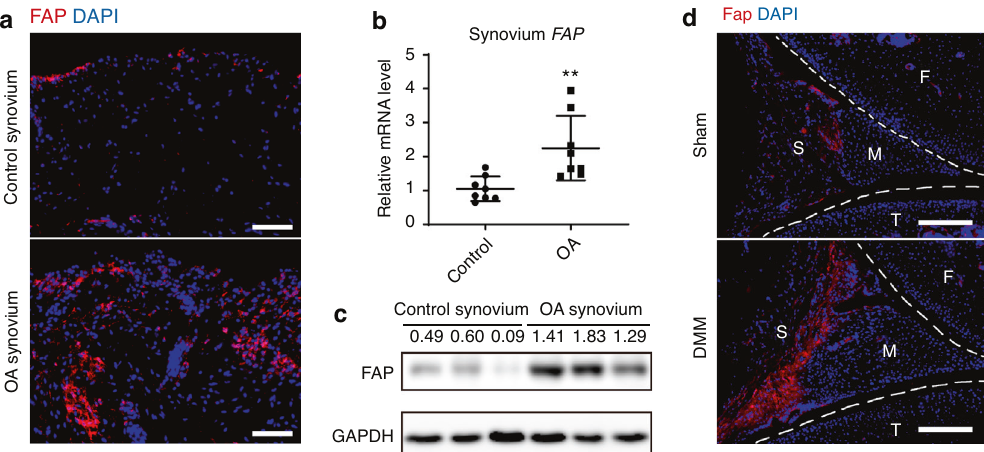
Fig. 1 Expression analysis of Fap in OA synovium. a Immunostaining of human FAP in the synovium of control and OA patients. DAPI staining indicates the nucleus. Scale bars: 100 μ m. b qPCR analysis of human FAP mRNA levels in the synovium of control and OA patients ( n = 8 samples per group). c Western blot analysis of human FAP protein levels in the synovium of control and OA patients ( n = 3 samples per group). d Immunostaining of mouse Fap in the knee joint of sham and DMM-treated mice. Sham or DMM surgery was performed in 8-week- old Fap LacZ/ + mice, which were sacri fi ced 8 weeks later, and LacZ immunostaining was used to detect Fap expression at the posterior horn of the medial meniscus (F: femur; T: tibia; M: meniscus; S: synovium). DAPI staining indicates the nucleus. Scale bars: 100 μ m. The statistical signi fi cance was assessed using two-tailed Student ’ s unpaired t tests. Data are presented as the mean ± SD (** P <